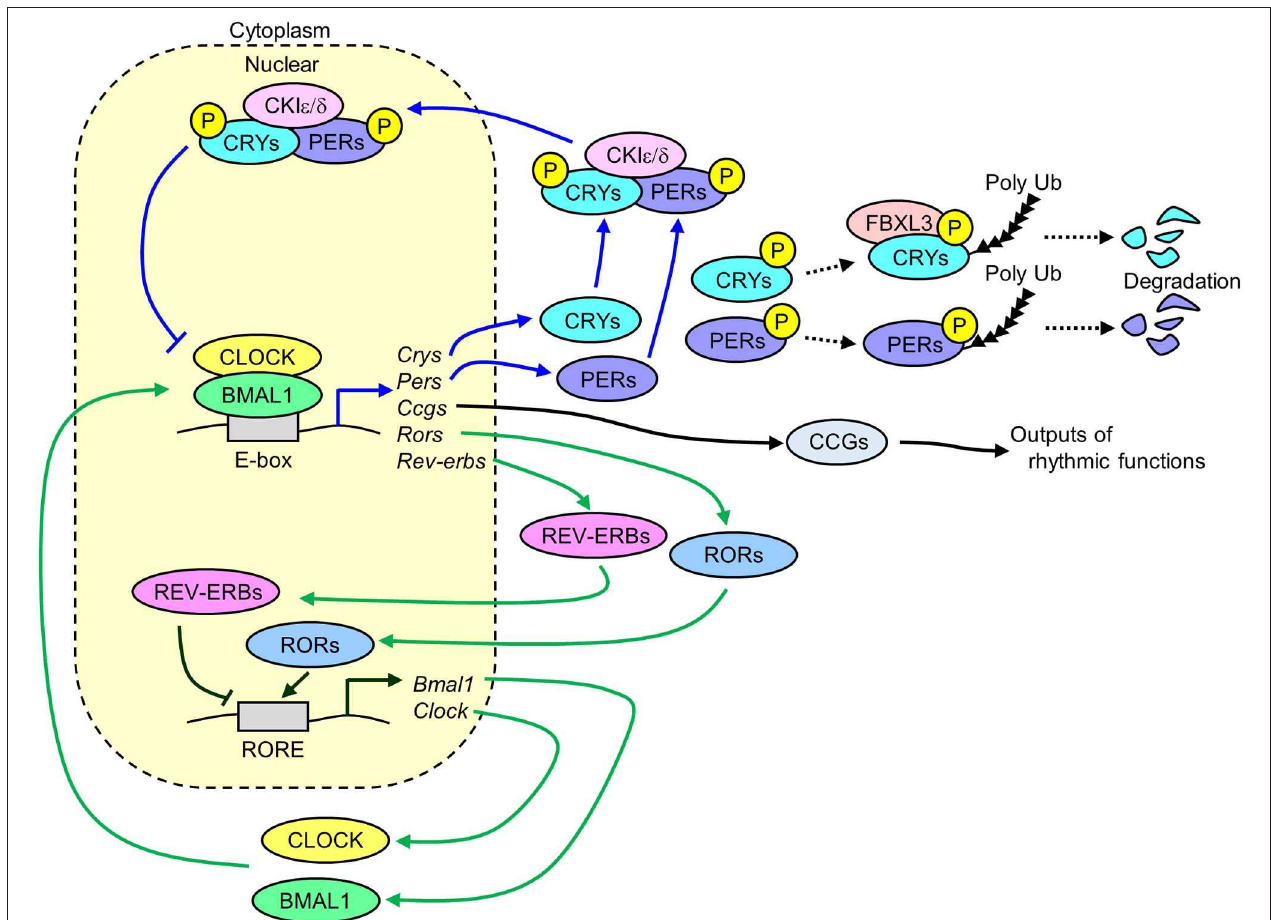
FIGURE 1 | Transcriptional and translational negative feedback loop of core molecular clocks in mammals. The heterodimer of CLOCK and BMAL1 activates the transcription of Crys , Pers , Rors , Rev-erbs, and Ccgs . The translated and phosphorylated PERIODs and CRYs form a complex along with CKI ε / δ and then this complex is translocated into the nucleus to inhibit its own transcription induced by the heterodimer of CLOCK and BMAL1 (blue lines). A part of phosphorylated CRYs and PERIODs is degraded via ubiquitin-proteasome pathways. The translated REV-ERBs and RORs inhibits and activates the transcription of Bmal1 and Clock genes via binding to RORE, respectively (green lines). The rhythmic expression of Ccgs results in oscillation of several physiological functions (Crys, Cryptochrome1/2; Pers, Period1/2; Rors, Retinoid-related orphan receptors; Rev-erbs, reverse-Erb receptors; Ccgs, Clock-controlled genes; CKI ε / δ , Casein kinase 1 ε / δ ; RORE, retinoic acid receptor response